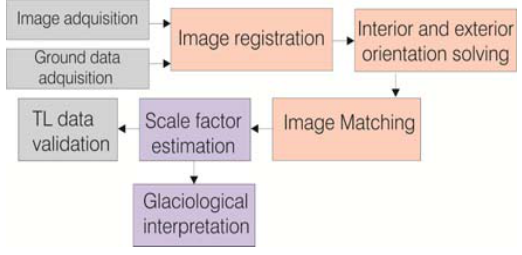
Figure 4. Workflow of the present